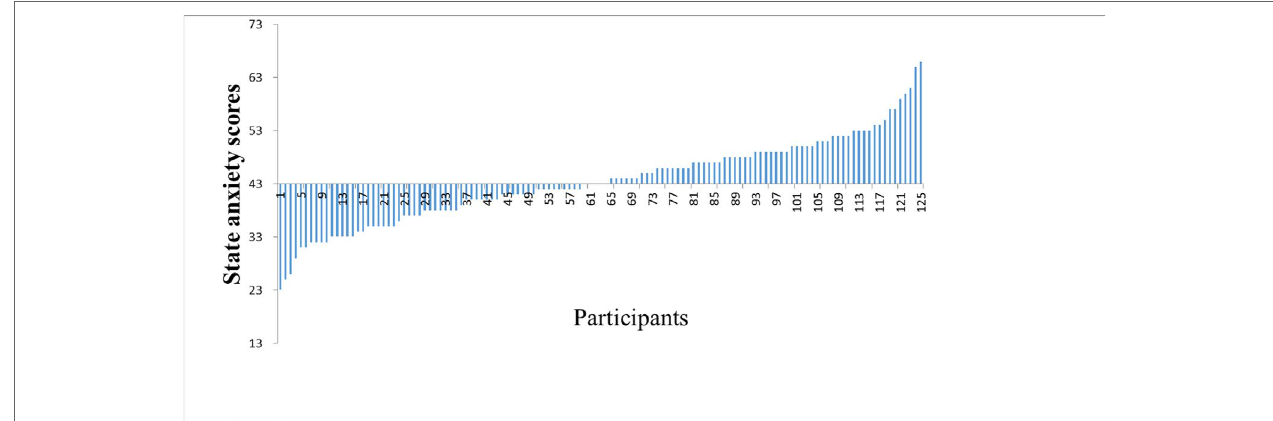
FIGURE 1 | The distribution of the state anxiety scores in the healthy